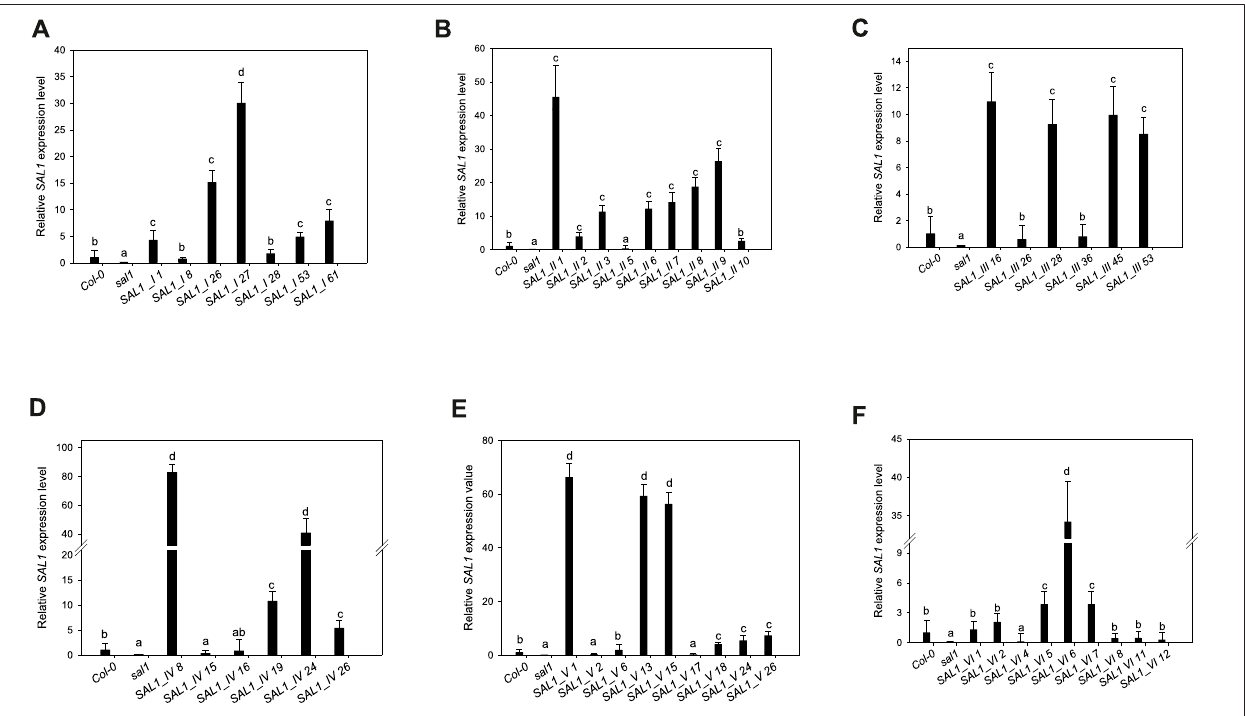
FIGURE4| Expressionlevelsof SAL1 indifferenttransgeniclines.Plantsweregrownfor5 weeksonsoilinshortdaysinacontrolledenvironmentchamber,mRNA wasisolated,andtheexpressionof SAL1 analyzed. SAL1 expressionlevelsfor SAL1_I (nuclearlocalization) (A) , SAL1_II (cytosoliclocalization) (B) , SAL1_III (chloroplastic localization) (C) , SAL1_IV (mitochondrial localization) (D) , (E) SAL1_V (chloroplastic and mitochondrial localization) (E) , and SAL1_VI (nuclear and cytosolic localization) (F) .TheseSAL1expression datashowthe mean ± SEfrom twoindependentexperiments with fi vebiologicalreplicatesineach ( n (cid:1) 10). Relativeexpression values werenormalized to Actin2 andcomparedwiththeexpressionlevelinwild-typeplants(Col-0 (cid:1) 1). Differentletters indicatesigni fi cantdifferencesamongmeansbasedon t -tests at p <